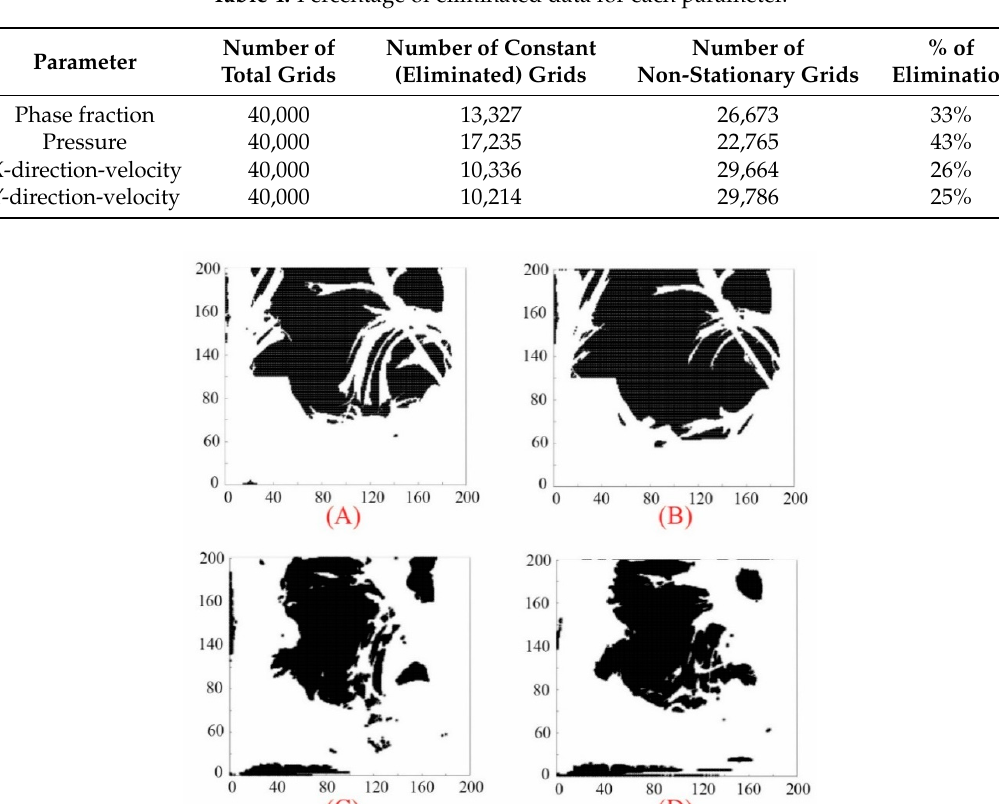
Figure 26. Root mean square equation (RMSE) of the cascading condition for Model Ⅱ .